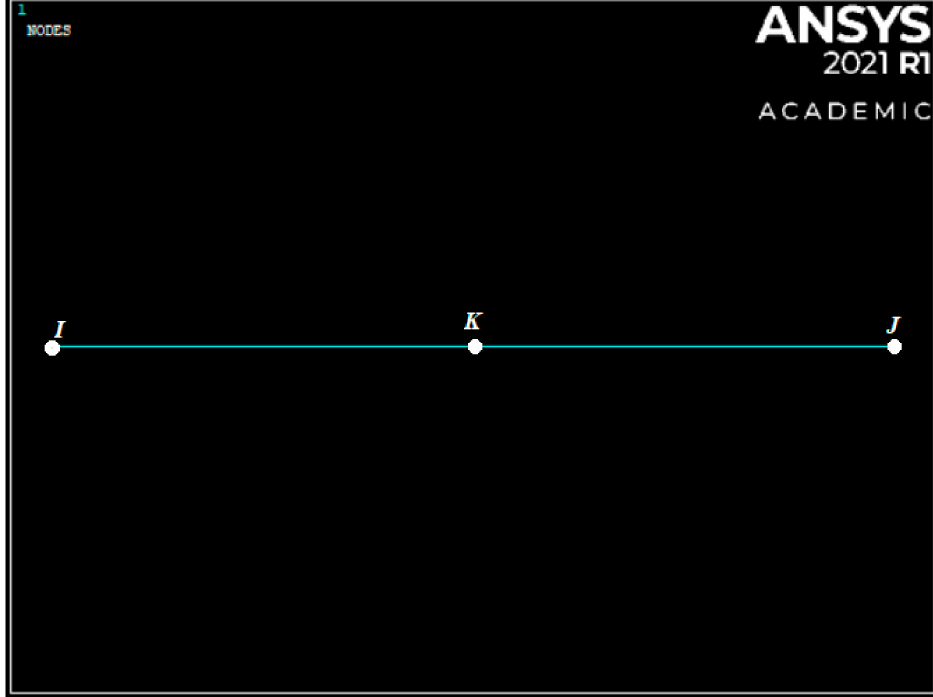
Figure 14. The geometry of the structural BEAM189 element with the three nodes ‘I’, ’J’, and ‘K’